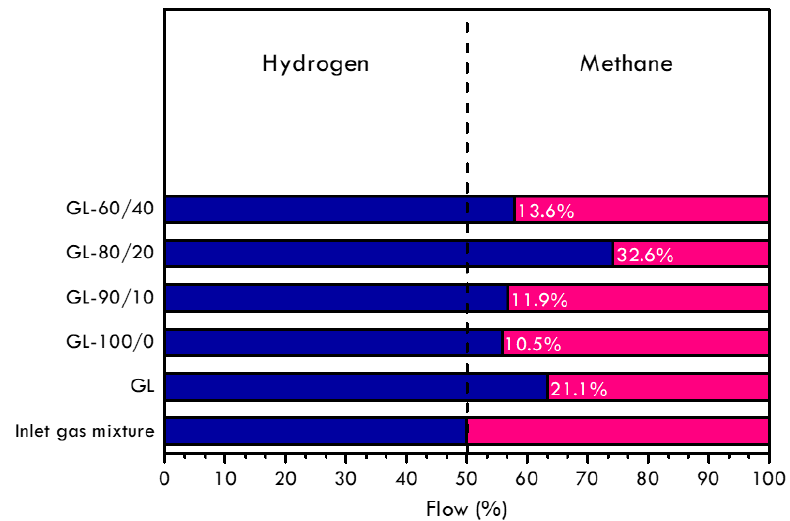
Figure 10. Outlet gas mixtures composition (v%).